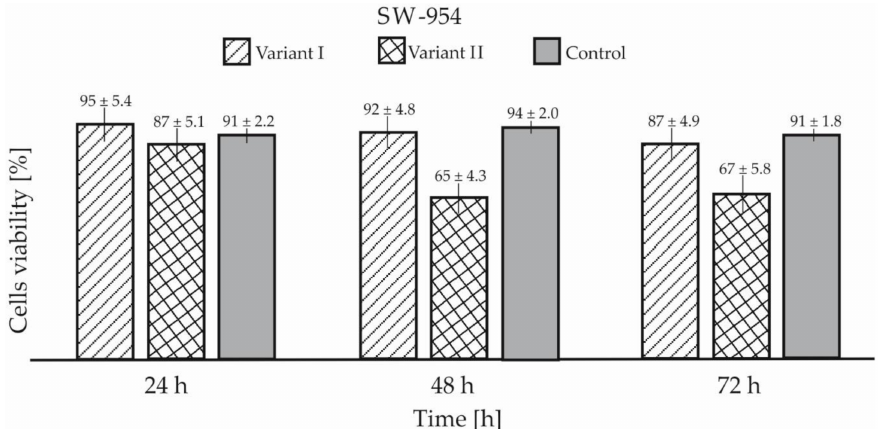
Figure 10. Cell viability of MDA-MB-231 in both tested variants.